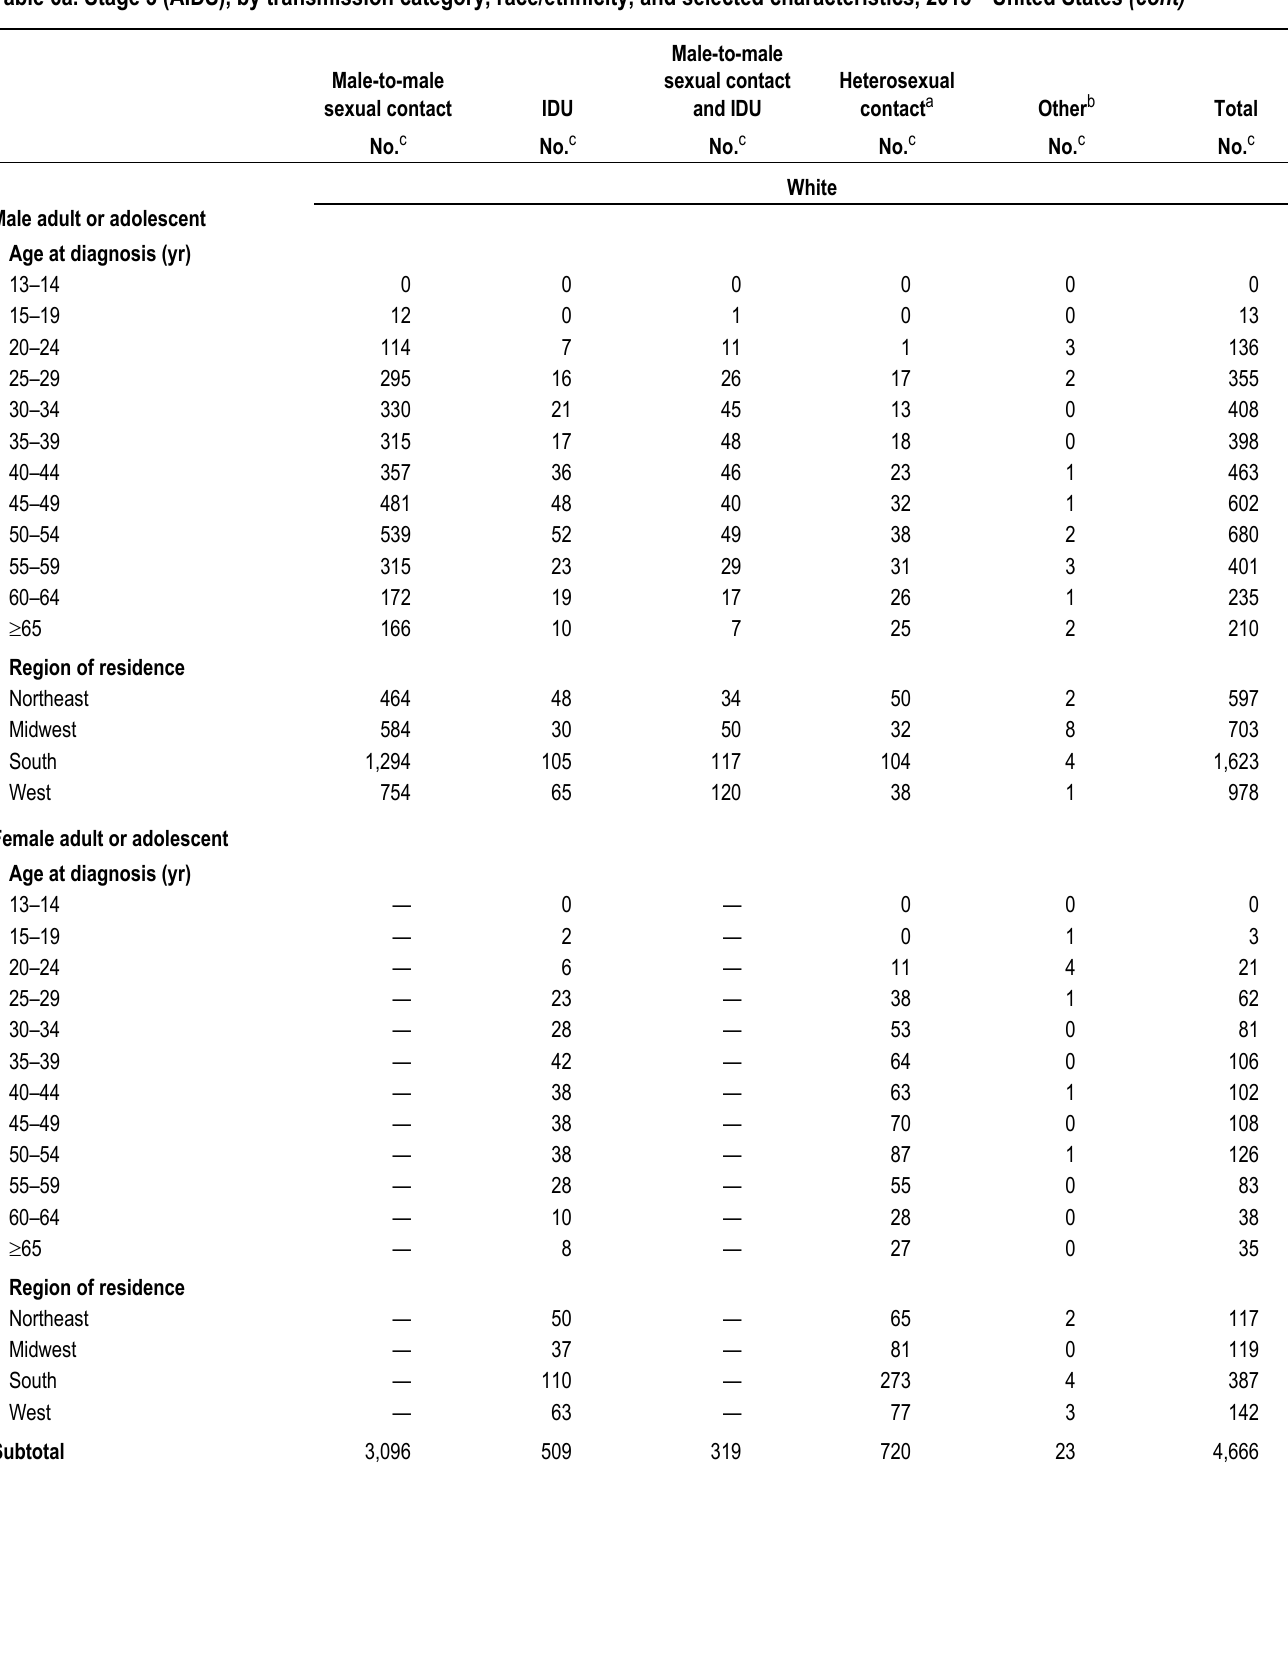
Table 6a. Stage 3 (AIDS), by transmission category, race/ethnicity, and selected characteristics, 2015—United States